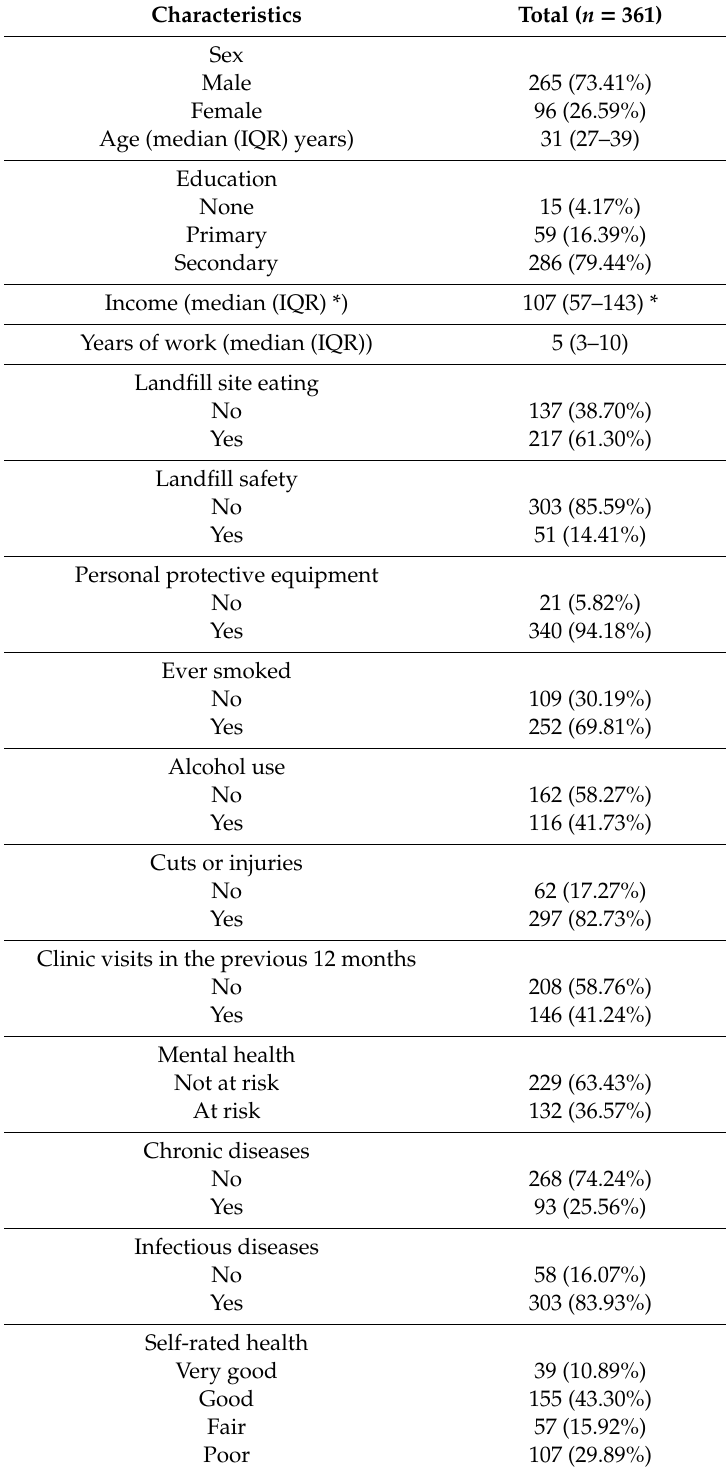
Table 1. Description of demographic, lifestyle and health